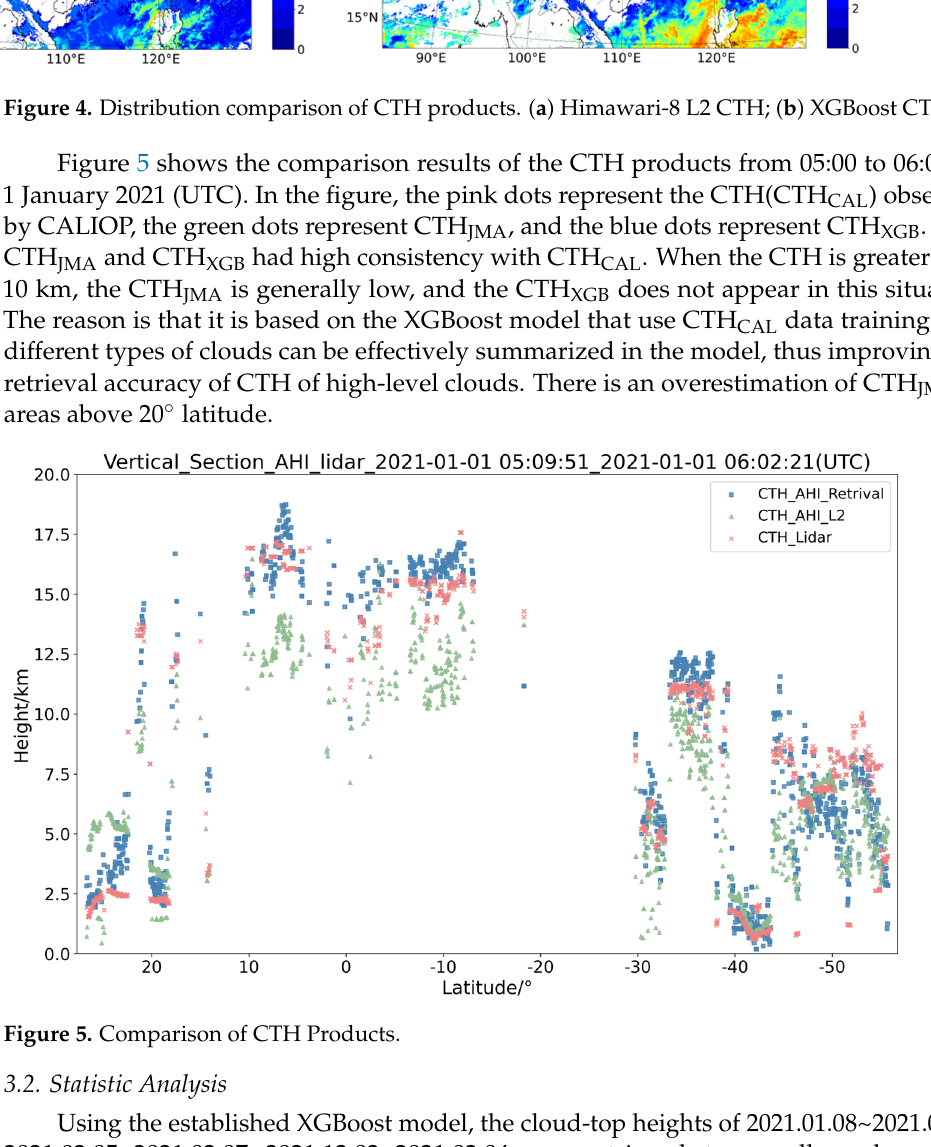
Figure 4. Distribution comparison of CTH products. ( a ) Himawari-8 L2 CTH; ( b ) XGBoost CTH.